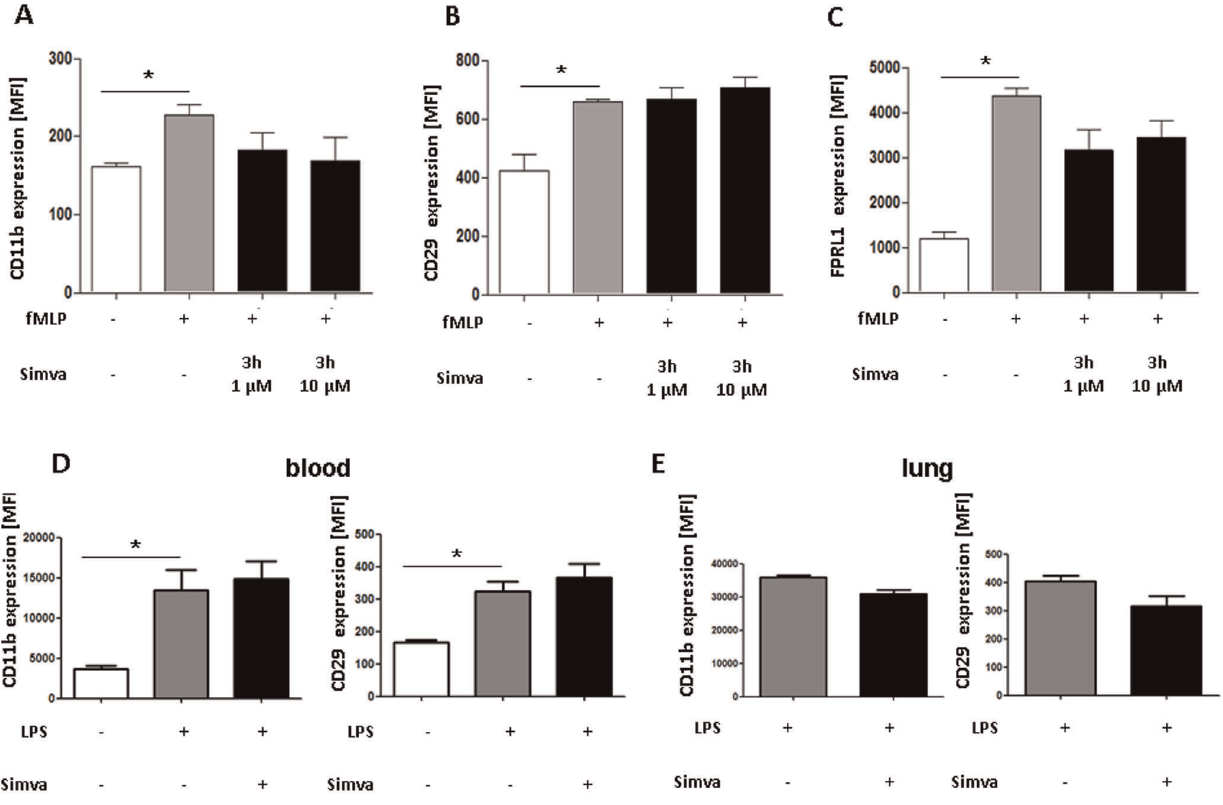
Figure 5. Influence of simvastatin on neutrophil degranulation invitro (A–C) and invivo (D + E). Isolated human neutrophils were pre- treated with Simvastatin (3 hours, 1 or 10 m M) and then activated with fMLP. MFI of surface expression of CD11b (A), CD29 (B) and FPRL1 (C) as measured by flow cytometry after staining with directly conjugated antibodies (n=3–6; repetition=4). D + E In vivo degranulation after LPS inhalation. Mice were challenged with LPS via inhalation and sacrificed 4 hours later. After isolation of neutrophils from the blood and the lung, MFI of surface expression of CD11b and CD29 as measured by flow cytometry after staining with directly conjugated antibodies (n=4–6). Statistical significance was tested using one way ANOVA with Newman-Keuls Multiple Comparison test. * indicates significant difference in comparison to the fMLP or the LPS group.